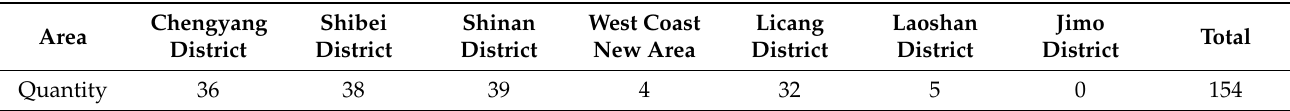
Table 3. Number of areas with high risk of epidemic situation within seven municipal districts of